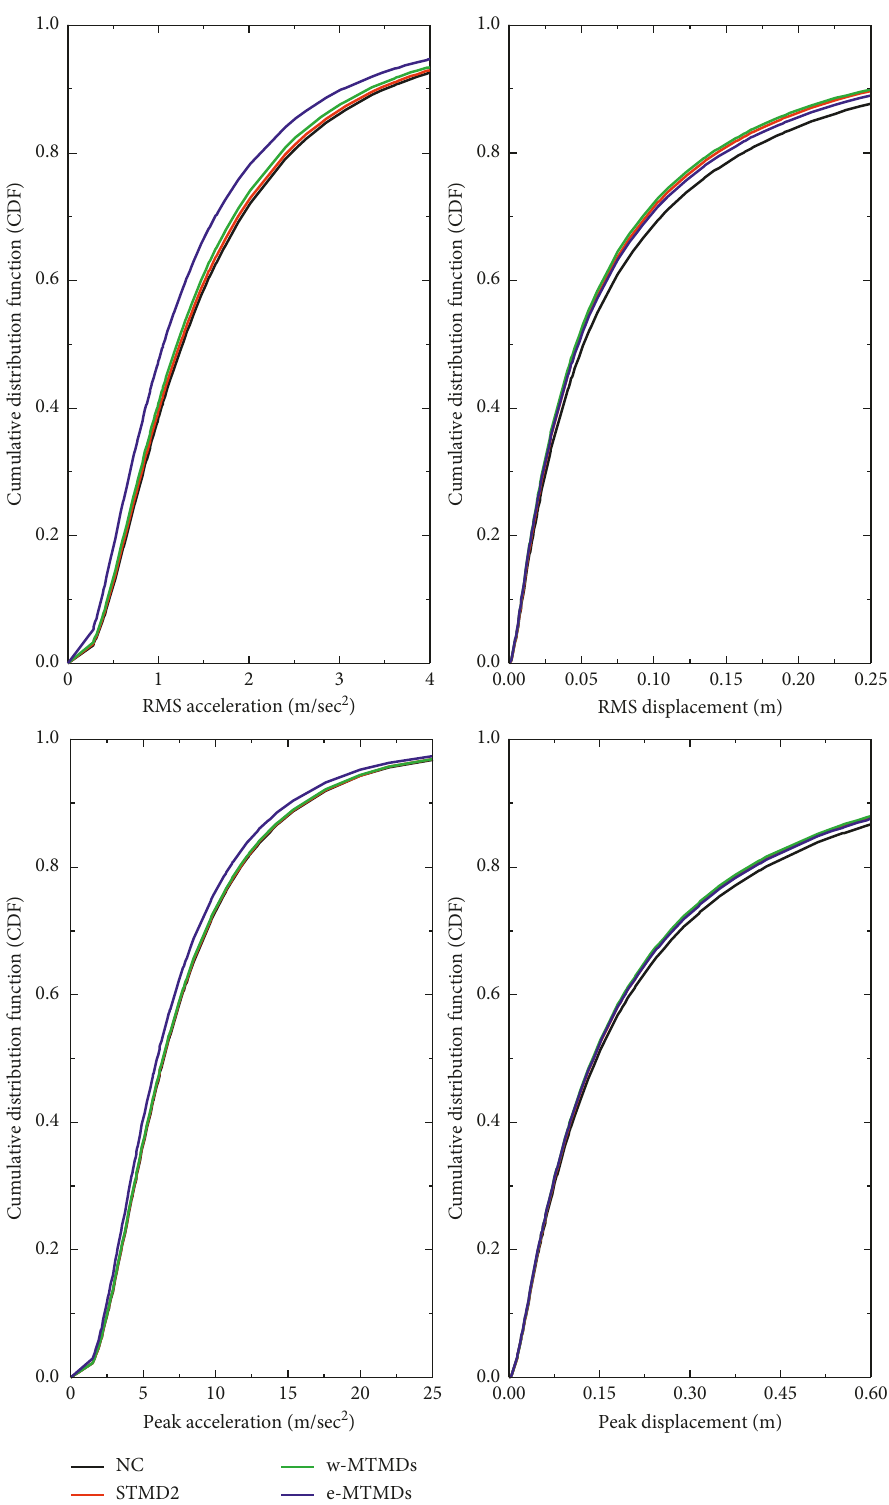
Figure 3: The CDF of responses for the NC, STMD, w-MTMDs, and e-MTMDs subjected to earthquake